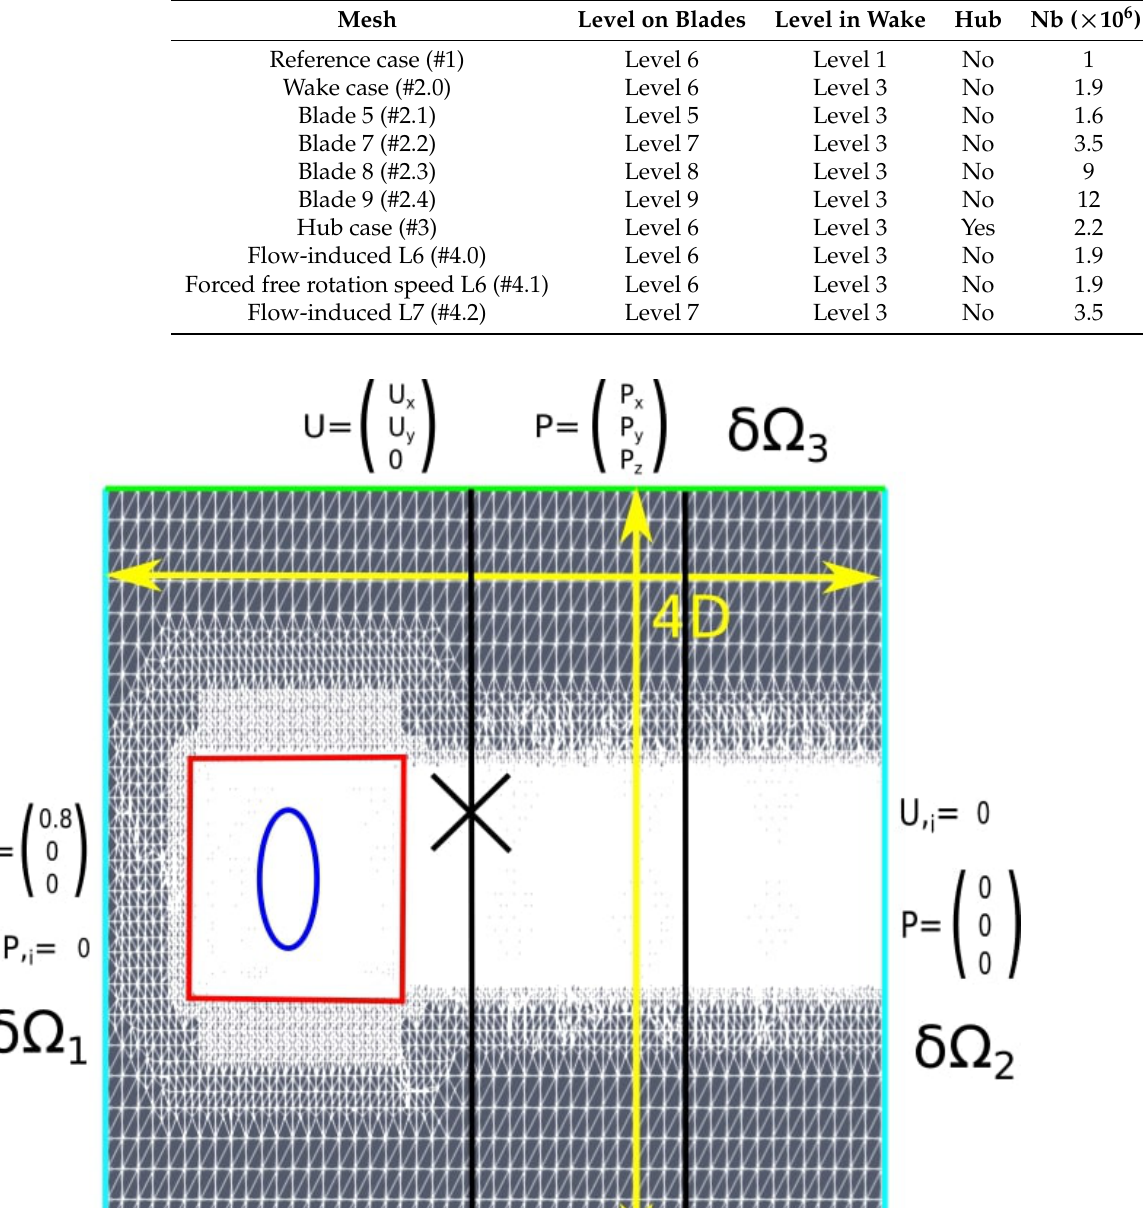
Table 2. Summary of test cases for the horizontal axis turbine according to the level of refinement on the blades and in the wake, the presence or absence of a hub, and the total number of points in the mesh (Nb).